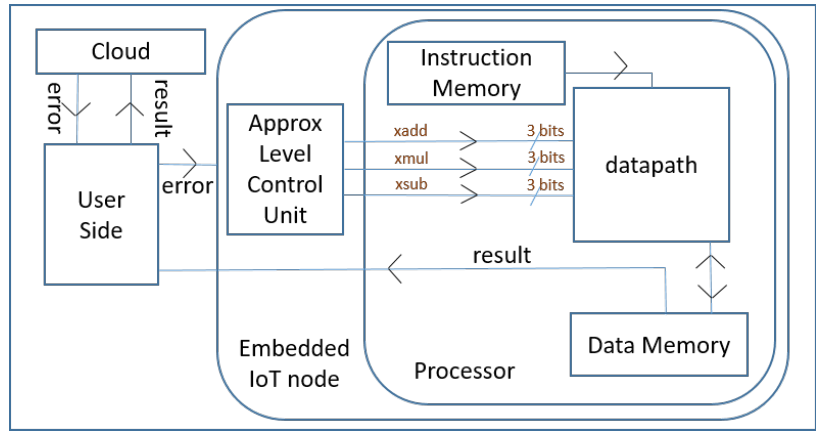
Figure 2. Flow diagram of dynamic accuracy control in our Approximate IoT processor.